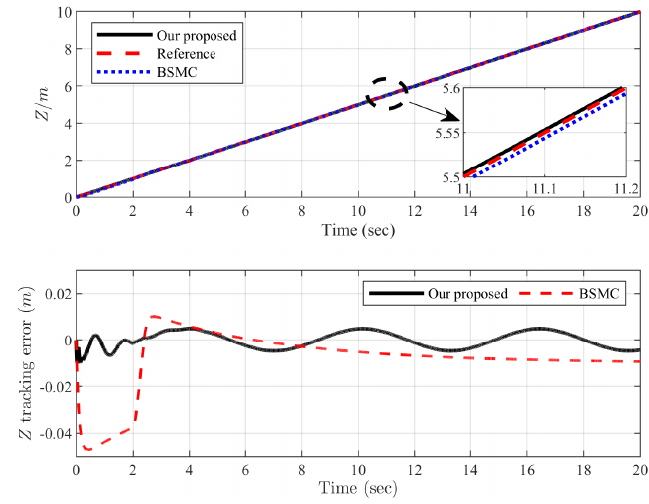
Figure 8. The control performance and tracking errors in relation to z .